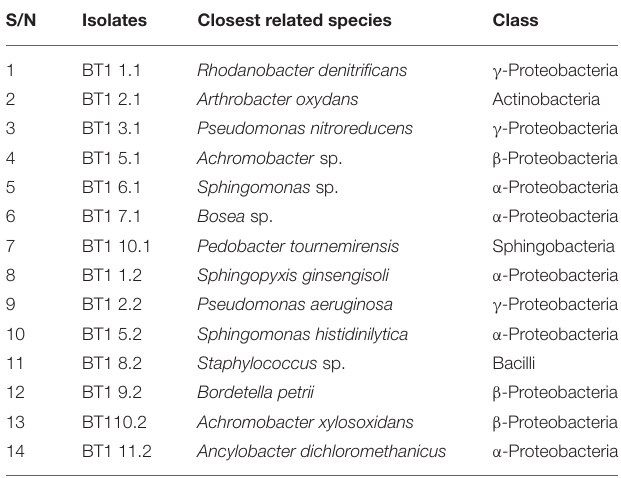
TABLE 1 | List of bacterial isolates derived from the first and second enrichments (denoted by “1” and “2” as the last digit in the isolate names, respectively) of T1 soil communities on medium with